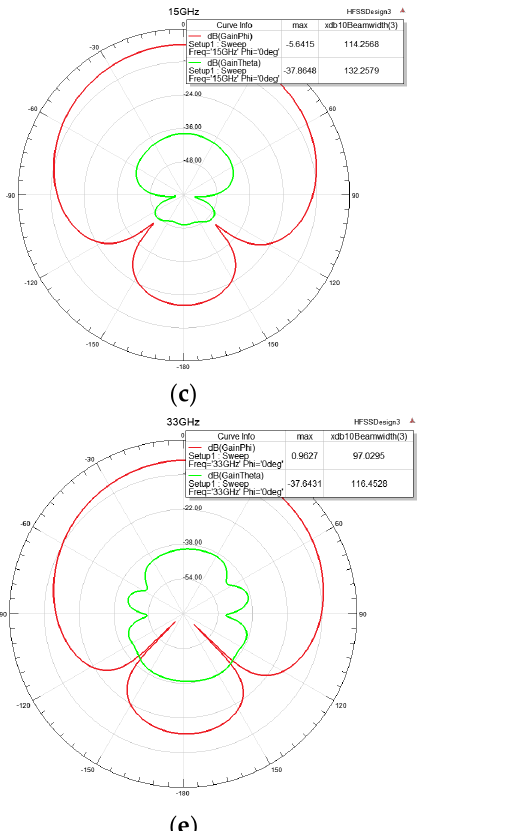
Figure 4. Electrical properties of single-polarized magnetoelectric dipole antennas: ( a ) the @E plane active standing wave; ( b ) the @H plane active standing wave; ( c ) 15 GHz direction pattern result; ( d ) 26.5 GHz direction pattern result; ( e ) 33 GHz direction pattern result; and ( f ) 40 GHz direction pattern result.